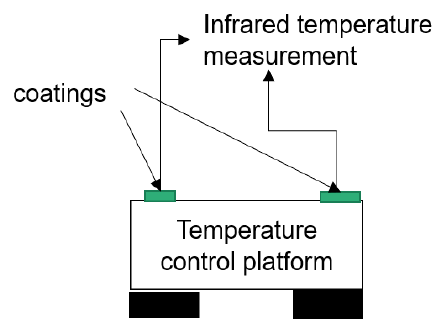
Figure 2. Temperature control test platform.